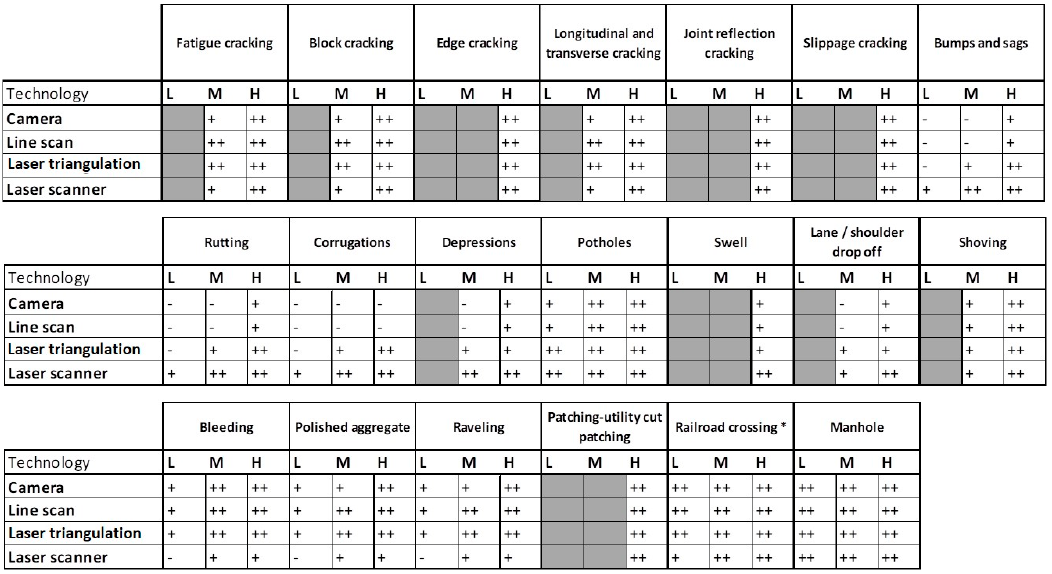
Figure2. Distresses—Technologies relation. Figure 2. Distresses—Technologies